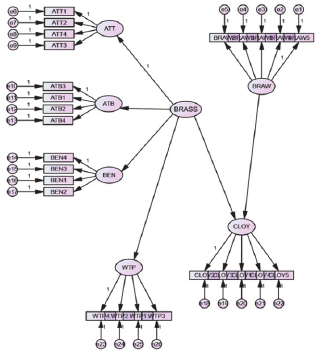
Fig. 1. Proposed research model (Source: Outputs from AMOS,